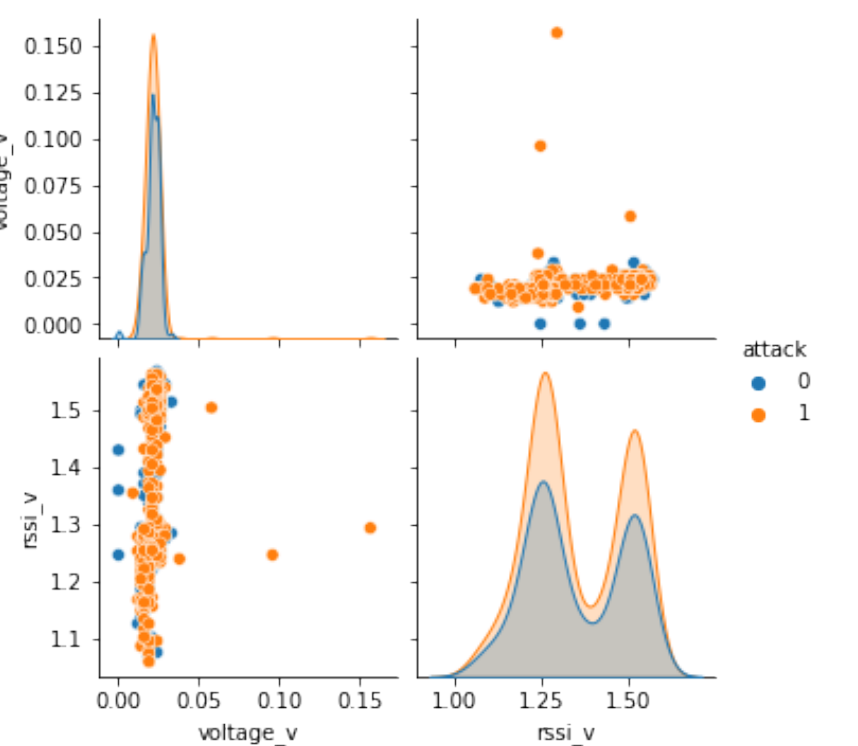
Figure 15. Impact of switching states and received signal indicator of switching states on cyberattack status.